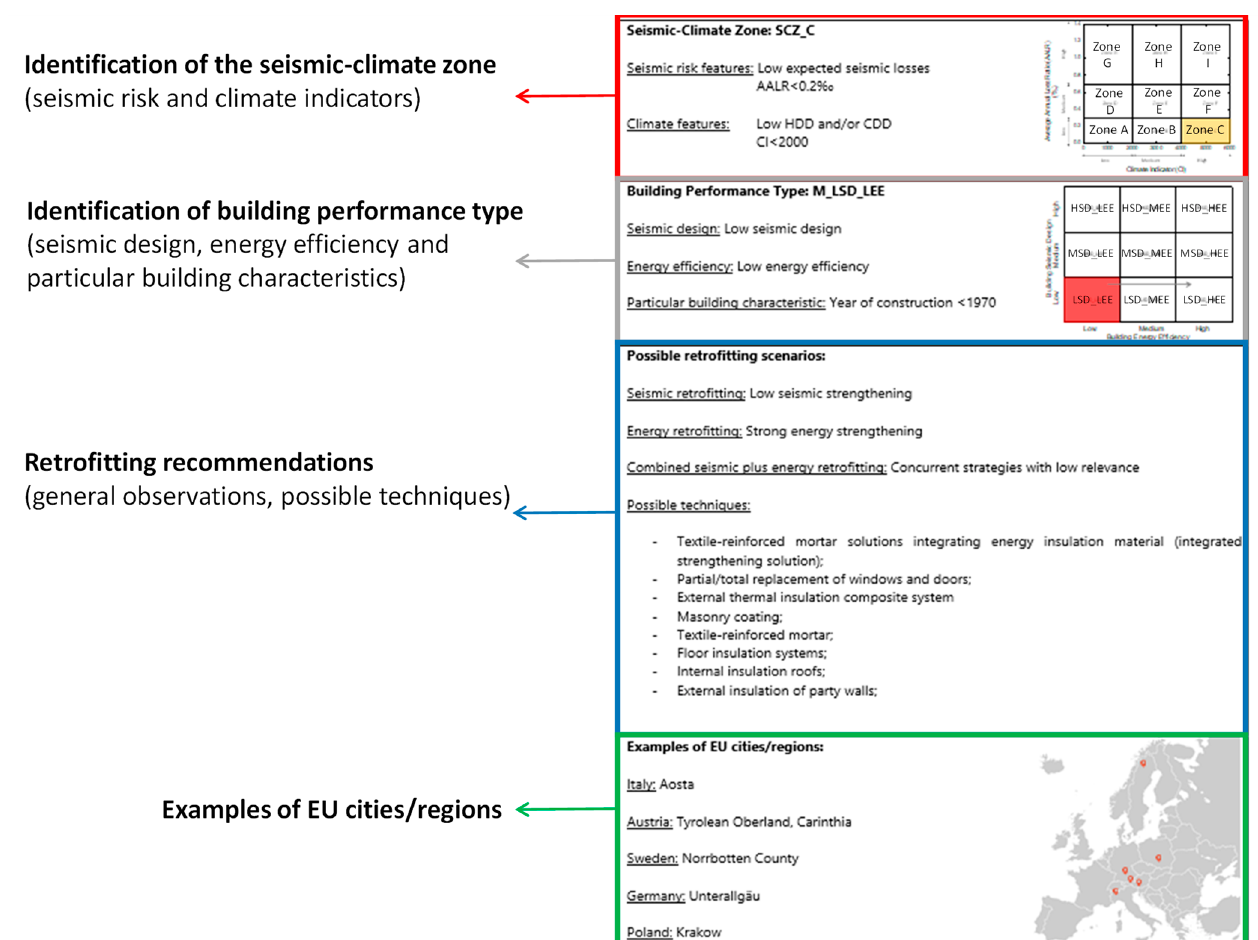
Figure 10. Framework of the datasheets produced for each